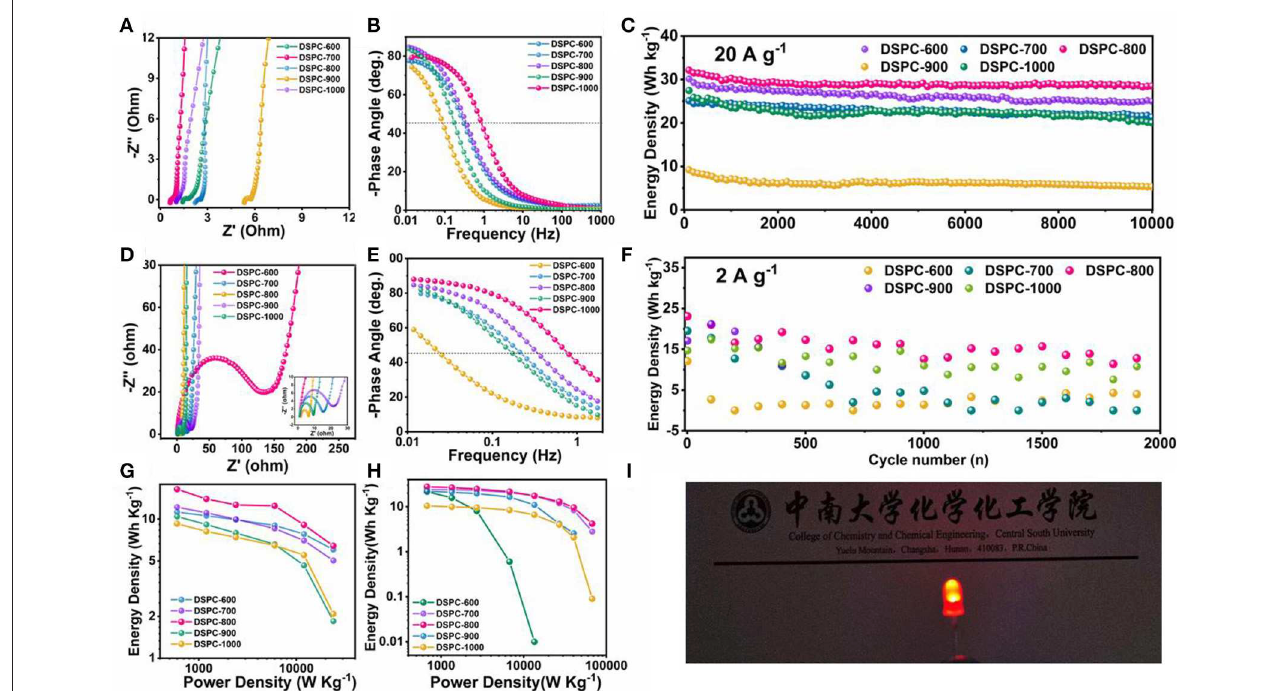
FIGURE 5 | (A) EIS analysis in 6M KOH, (B) Bold plot in 6M KOH, (C) cycle performance in 6M KOH, (D) EIS analysis in organic electrolyte, (E) Bold plot in organic electrolyte, (F) cycle performance in organic electrolyte, (G,H) Ragon plot in 6M KOH and organic electrolyte, (I) optical picture of device of DSPC-800 in organic